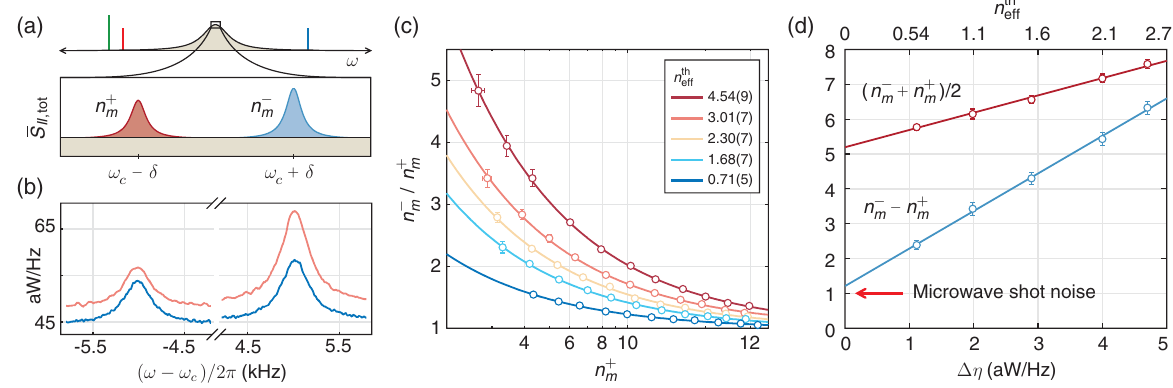
FIG. 3. Sideband asymmetry. (a) Pump scheme. Three tones are placed about the microwave resonance. Two probe tones generate up- converted (red) and down-converted (blue) sidebands. An additional tone (green) cools the mechanical mode. (b) Sideband spectra. ¯ ω (cid:3) measured at n th S ¼ 0 . 60 (blue) and 2.5 (orange) with ¯ n m ¼ 5 . 3 and 7.1, respectively. (c) Sideband asymmetry. The ratio n − m =n þ m II; tot ½ eff versus n þ is plotted for increasing noise injection. (d) Sideband imbalance (blue) and sideband average (red) versus the measured noise m − n þ n þ = 2 exhibit a linear trend with Δ η . The imbalance at Δ η ¼ 0 is the increase Δ η . Sideband imbalance n − and average ð n − m m m þ m Þ quantum imbalance due to the squashing of fluctuations of the microwave